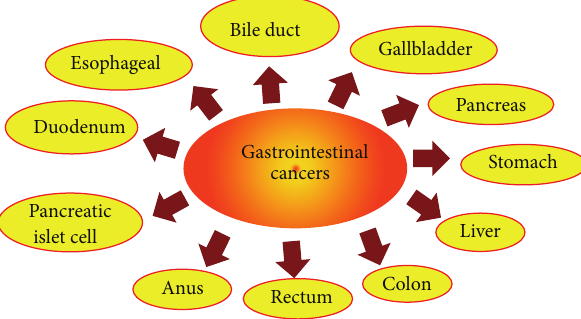
Figure 1: Different cancer types which are categorized under gas- trointestinal cancer.